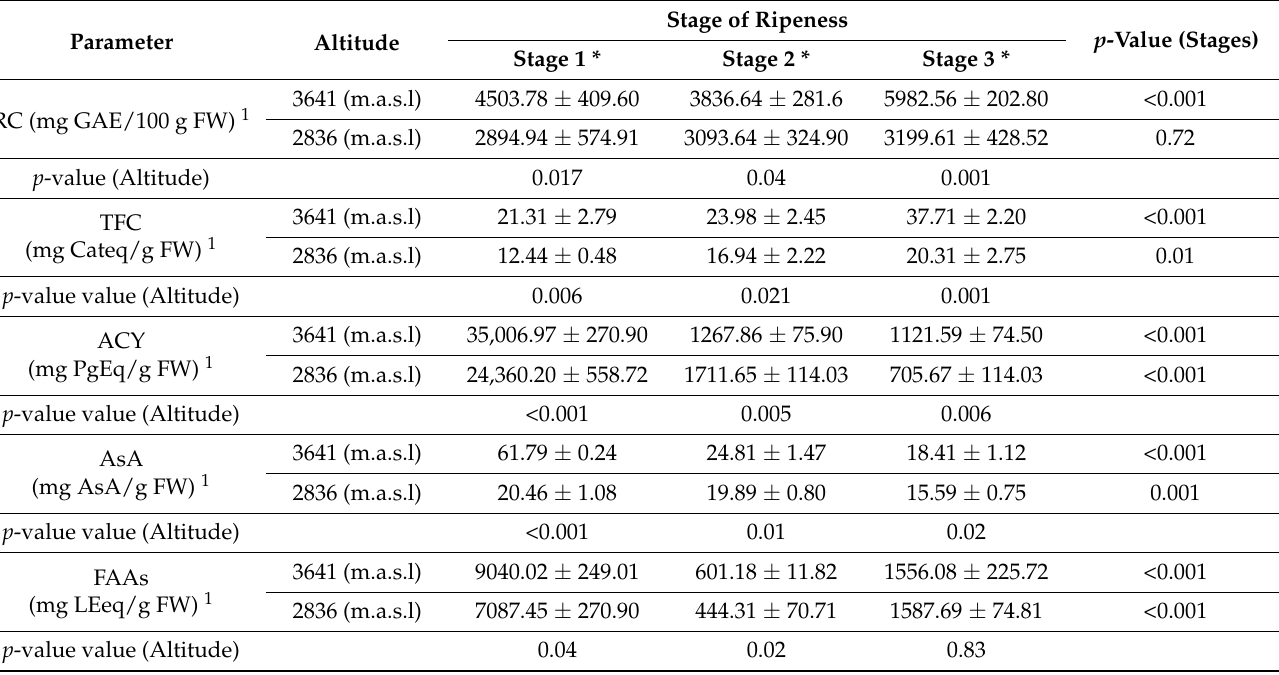
Table 4. Chemical composition of Andean blueberries ( V. floribundum Kunth) as affected by site altitude and ripeness